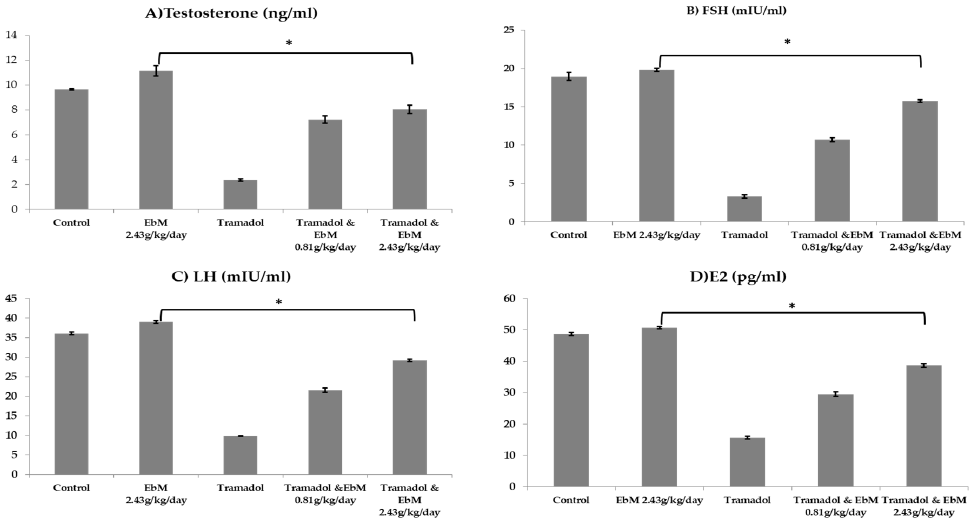
Figure 4. The e ff ect of oral uptake of E. brevicornum extract and / or tramadol on hormonal assay. Results Figure 4. The effect of oral uptake of E. brevicornum extract and/or tramadol on hormonal assay. Results are presented as mean ± SEM and evaluated using one-way ANOVA accompanied by are presented as mean ± SEM and evaluated using one-way ANOVA accompanied by Bonferroni’s test for multiple comparisons. * indicates significant di ff erent at p < 0.05 from the tramadol-treated group. tramadol-treated group. ( A ) Effect on testosterone level, ( B ) effect on FSH level, ( C ) effect on LH level, ( A ) E ff ect on testosterone level, ( B ) e ff ect on FSH level, ( C ) e ff ect on LH level, ( D ) e ff ect on E2 ( D ) effect on E2 level.